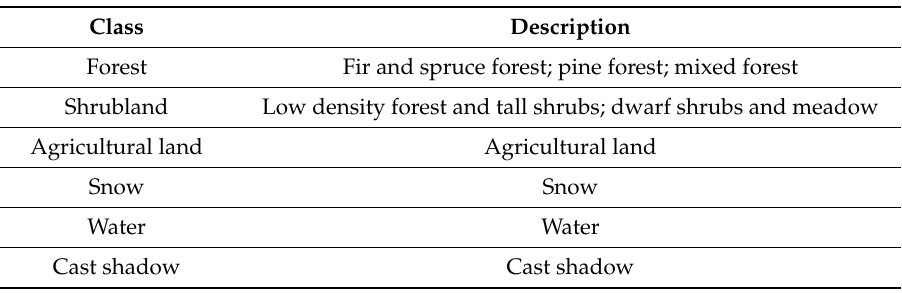
Table 2. Land cover